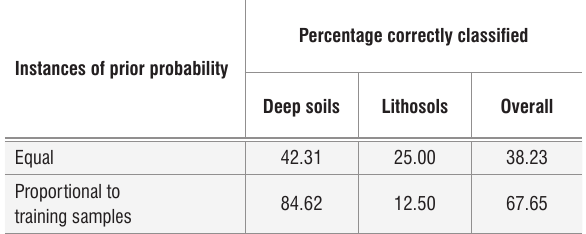
Summary of soil association prediction accuracy for Potsane